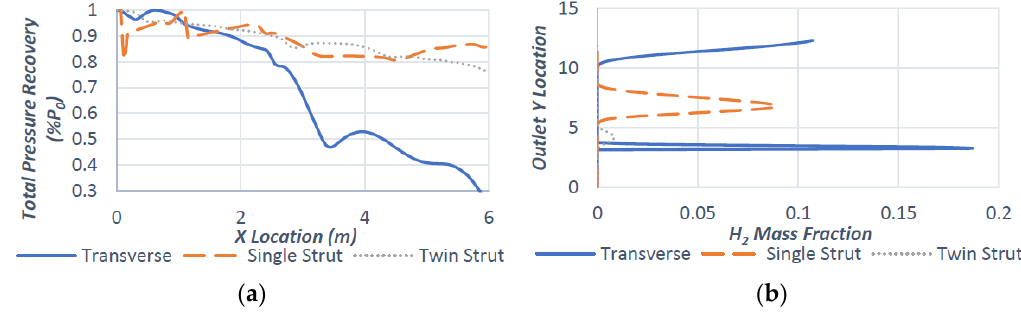
Figure 33. ( a ) Total pressure across combustor; ( b ) Remaining H 2 mass fraction across outlet.